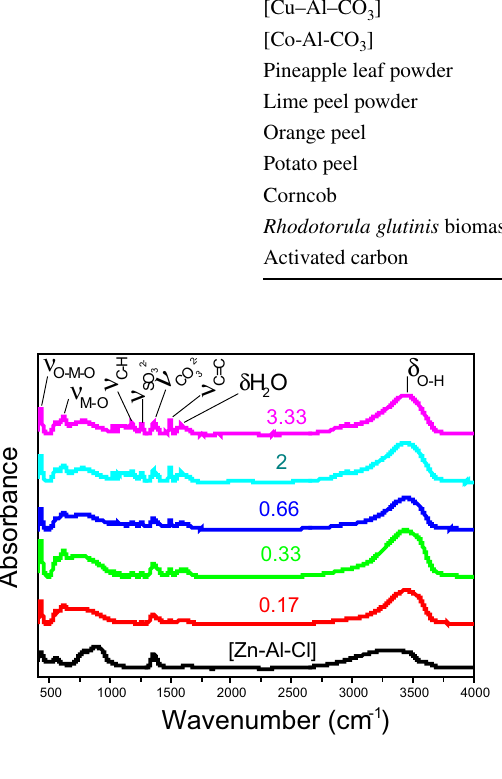
Fig. 9 IR spectra of phases obtained after retention of AG1 by 30 mg of [Zn–Al–Cl] at different mass ratio